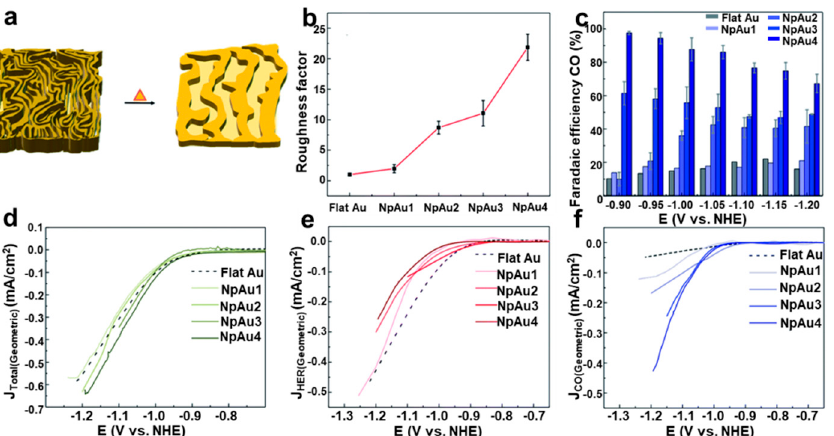
Figure 13. ( a ) Schematic diagram of nanoporous (Np) Au catalyst. ( b ) Roughness factors, ( c ) FE of CO, ( d ) total geometric current density, ( e ) partial geometric current densities of HER and ( f ) partial geometric current densities of CO over four porous Au catalysts. Reproduced with permission [88]. Copyright 2022, the Royal Society of Chemistry.